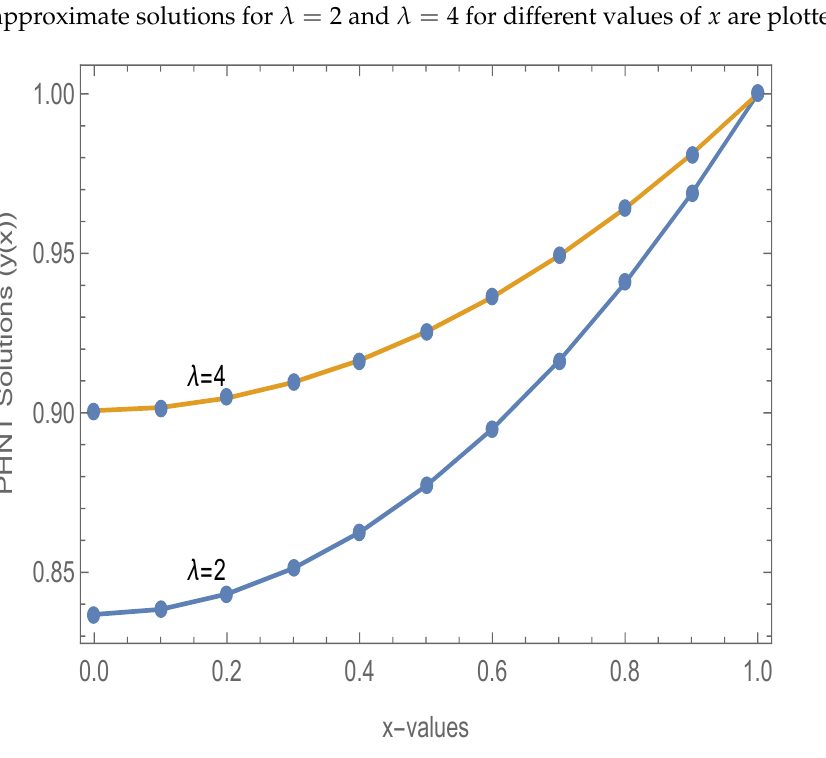
for different values of λ = 2 and λ = 4 for test 10